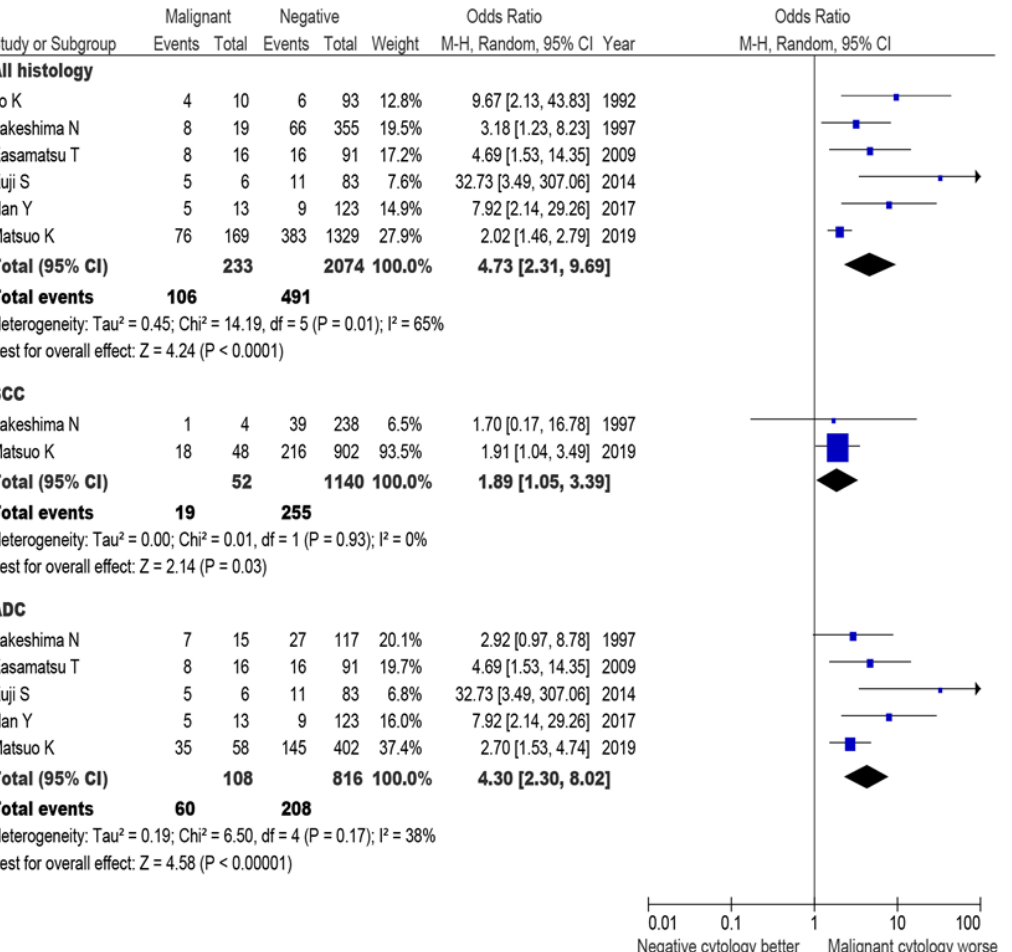
Figure 8. Recurrence risk for malignant peritoneal cytology (systematic review and meta-analysis). A forest plot from a random effects meta-analysis of six studies including our study stratified by inclusion criteria and ordered within stratum by year of publication and relative weight (%) of study. Centers of squares and horizontal bars through each indicate the point and 95% CI estimates of individual study odds ratio. Area of squares indicates the relative weights of the individual studies. Abbreviations: SCC, squamous cell carcinoma; and ADC, adenocarcinoma (including adenosquamous carcinoma in certain study).